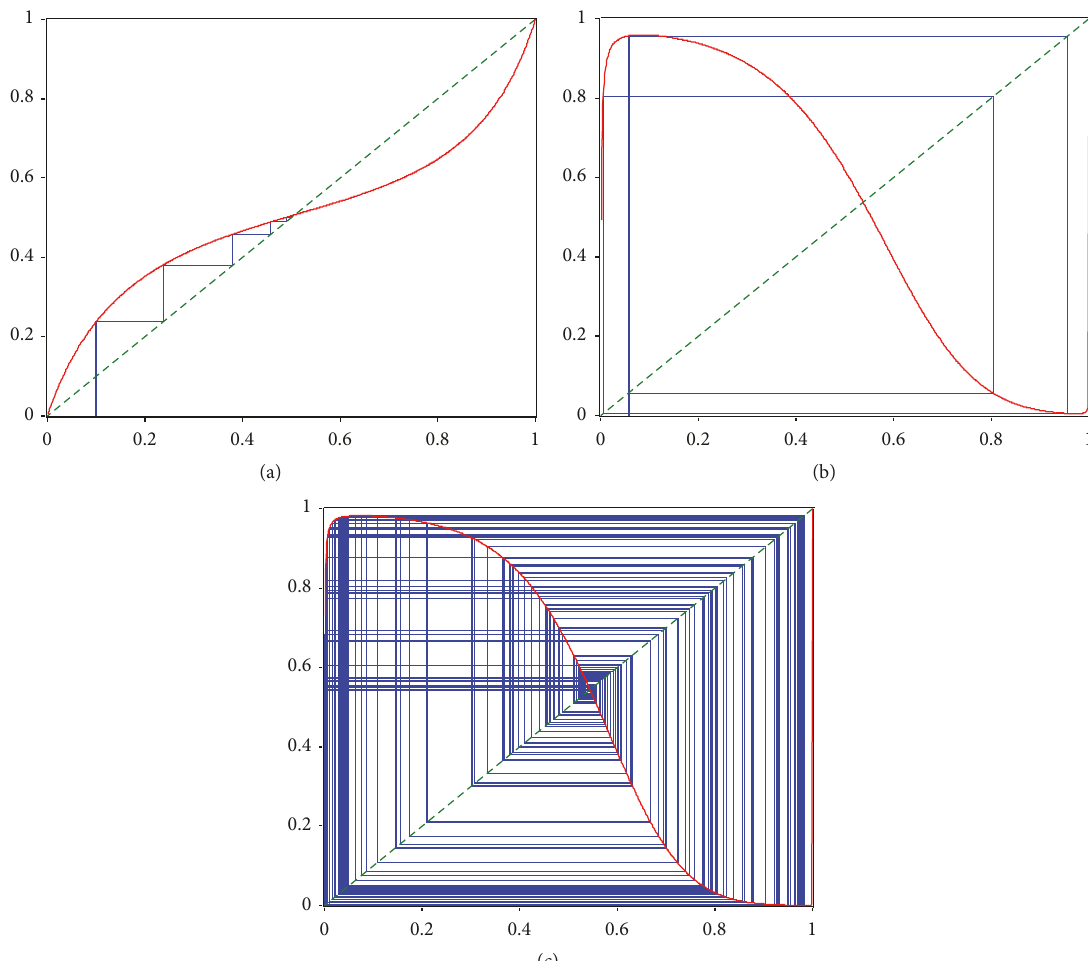
Figure 6: The graph of 𝑓 for 𝑤 𝑥 = 𝑤 𝑦 = 1 , and Δ = 0.2 , 𝑎(0) = 0.1 in (a), Δ = 0.40 , 𝑎(0) = 0.058 in (b) and Δ = 0.42 , 𝑎(0) = 0.1 in (c),